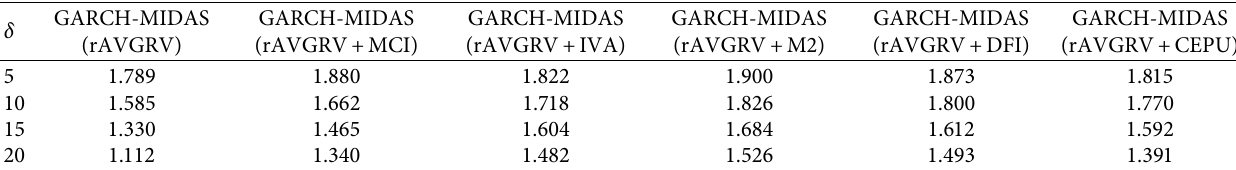
Table 6: Investment performance of different models based on rAVGRV.